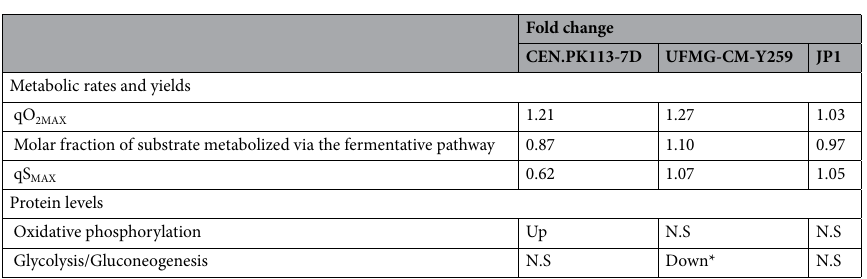
Table 1. Comparison of metabolic rates and respective protein level of S. cerevisiae CEN.PK113-7D, UFMG- CM-Y259 and JP1 during growth on sucrose relative to growth on glucose as sole carbon and energy source. Rates are taken from 3 . N.S. no significant change. *Proteins which reduced abundance: Acs1p, Adc1p,